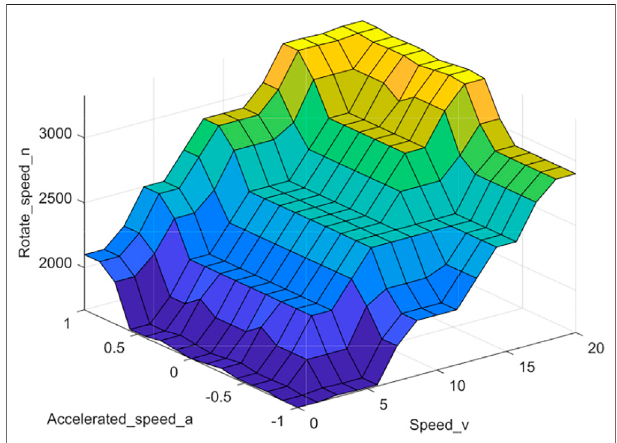
FIGURE 5 | Fuzzy control reasoning surface.